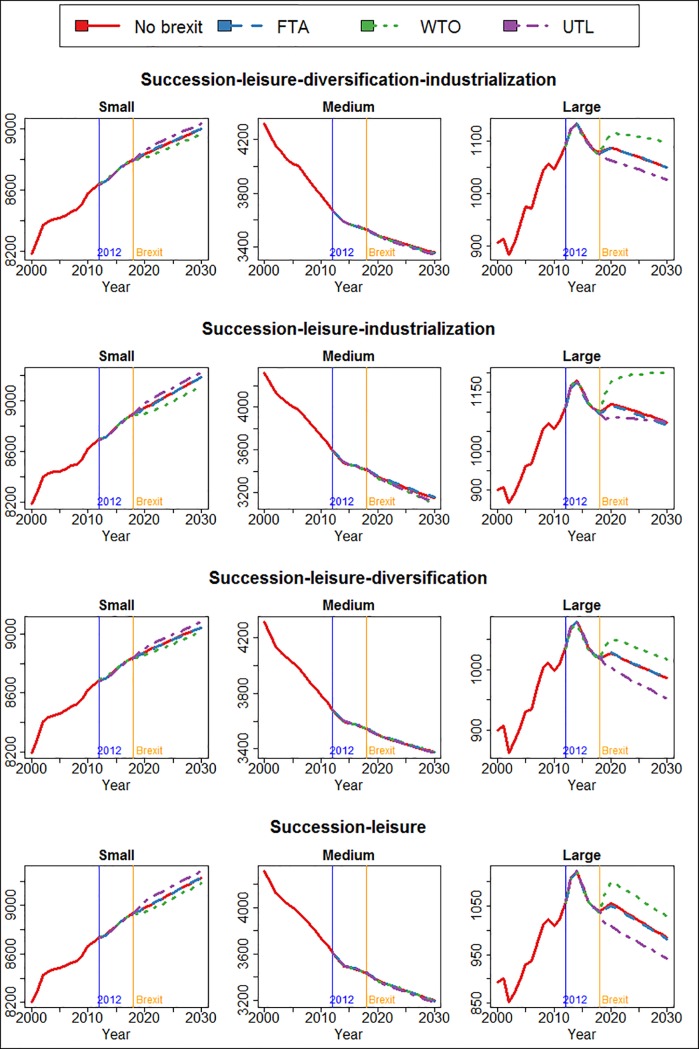
The number of small, medium and large cattle farms in the four Brexit scenarios predicted by the four models selected from POM.